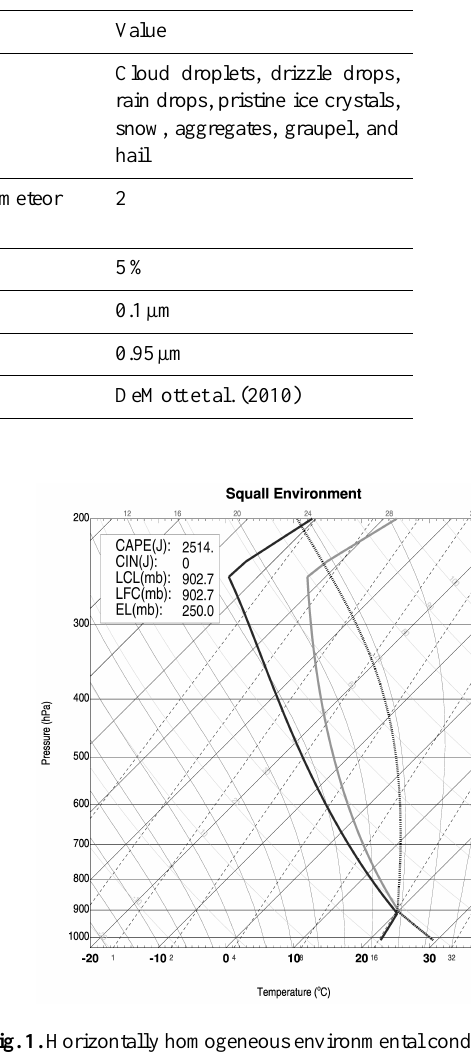
Fig. 1. Horizontally homogeneous environmental conditions initial- ized for the squall line. The thick gray line is the temperature profile and the thick black is the moisture profile. The thick dashed line is the adiabatic parcel curve (following Weismann and Klemp,